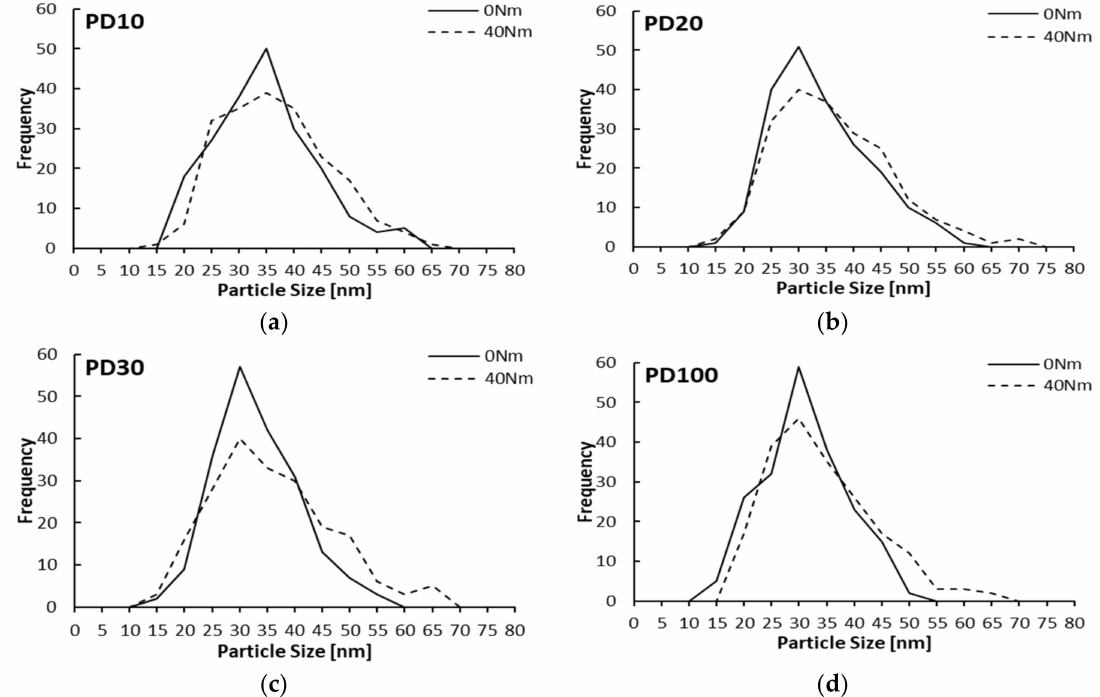
Figure 12. Particulate size distribution by test fuels and engine loads (Pilot BTDC 20 ◦ CA): ( a ) PD10, ( b ) PD20, ( c ) PD30 and ( d )